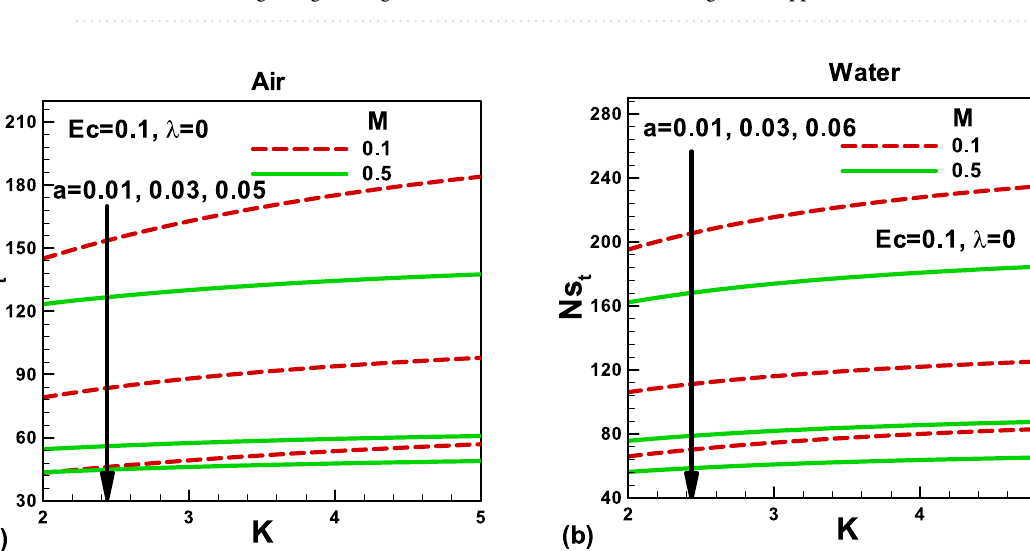
Figure 9. Effects of magnetic and porosity parameters on Nusselt number for (a) air and (b) water, when the free stream is moving along the negative x-axis and the needle is moving in the opposite direction.